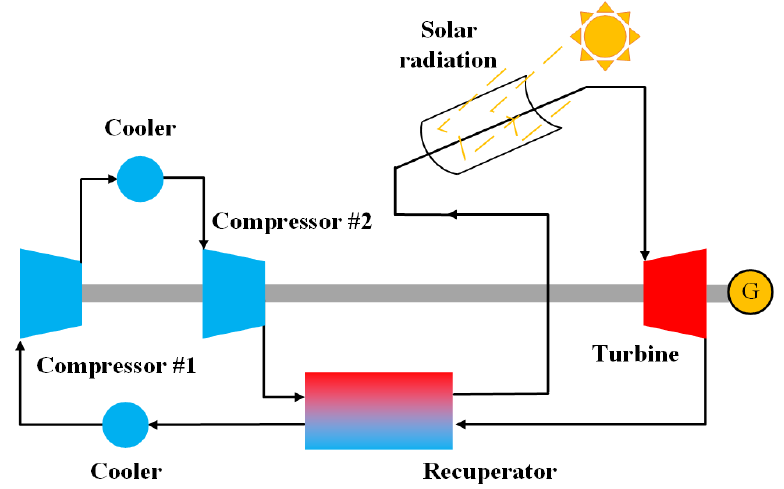
Figure 2. Configuration of the intercooling cycle.